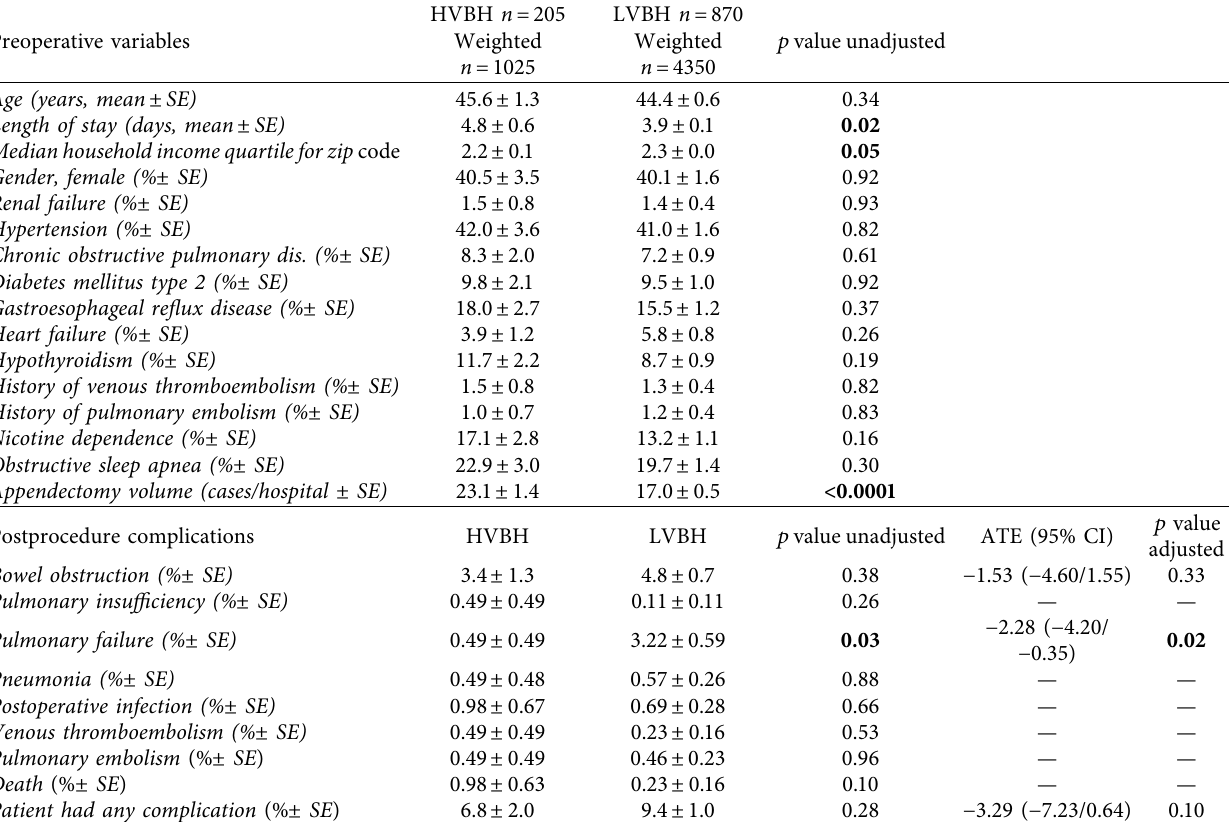
Table 6: Preoperative comorbidities and postoperative complications of patients with morbid obesity undergoing nonelective